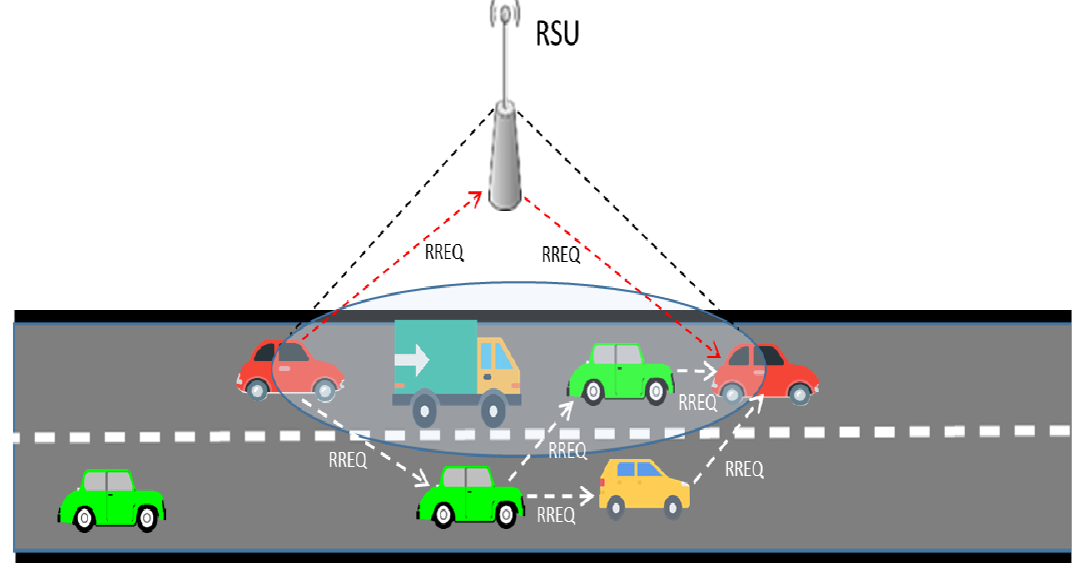
Figure 5. Multipath routing in vehicular